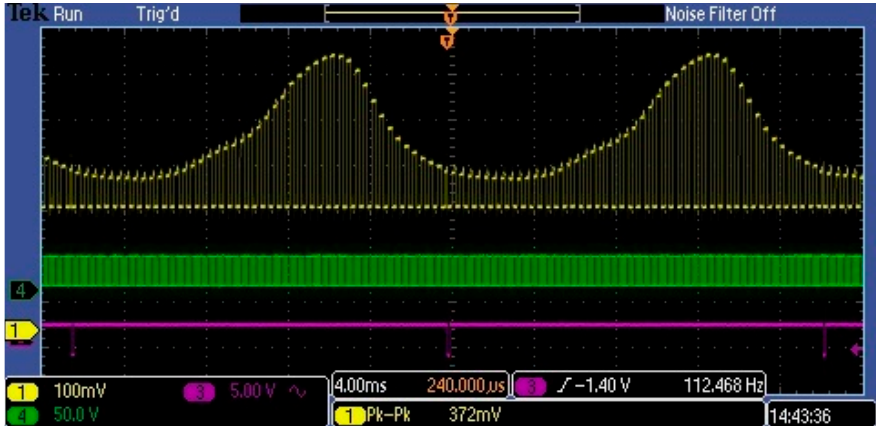
Figure 10. Measured waveforms of the MEMS spectrometer in the circuit shown in Figure 6: the yellow shows the Video signal, the green is the clock, and the purple is the end of scan C12666MA.